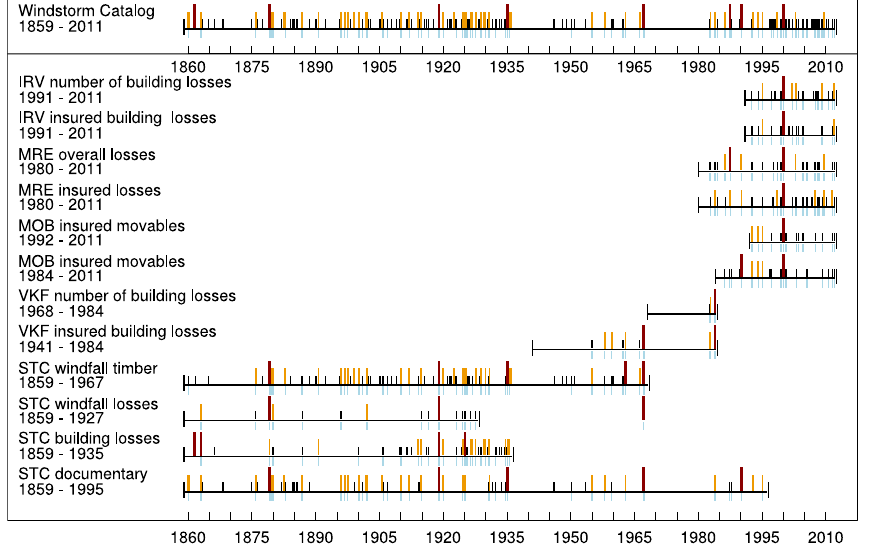
Figure 3. Compilation of the damage-based data set of windstorms (CAT-DAM): temporal distribution and severity classes of windstorm damage in the composite series (upper panel) and in the 12 contributing partial series (lower panel). Moderate windstorm events are symbol- ized by black vertical bars (yellow in Figs. 1 and 2), severe events are marked in orange and extreme events are red. Blue negative tips indicate concurrences in the partial series. Black horizontal distance bars indicate the analyzed period per series. Abbreviations of the sources are as follows: IRV – Intercantonal Reinsurance; MRE – Munich Re NatCatSERVICE; MOB – Swiss Mobiliar; VKF – Vereinigung Kantonaler Feuerversicherungen; STC – storm collection database from literature review. See text for details.